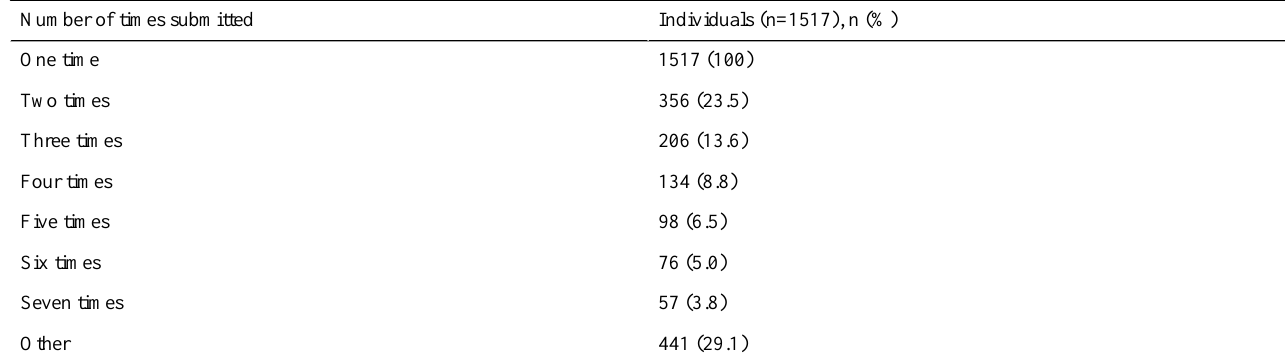
Table 3. Number of individual submissions in the assessment of burden of COVID-19